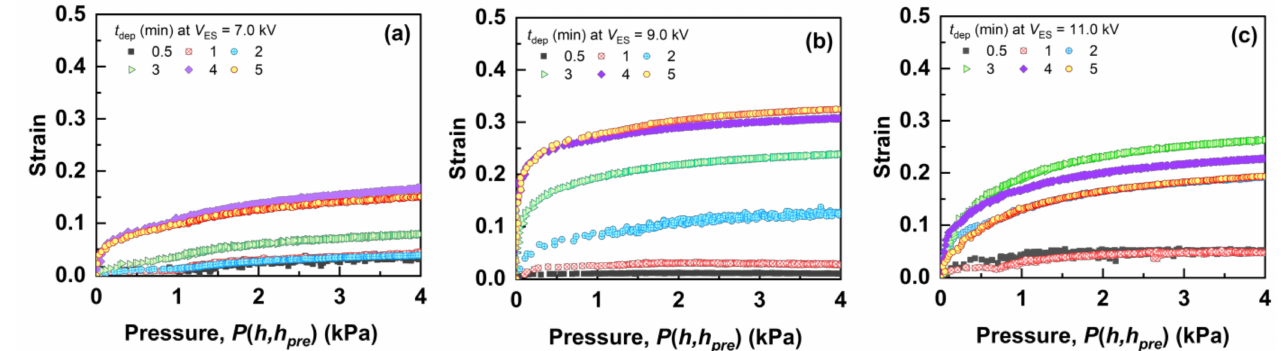
Figure 5. Strain–pressure characteristics of the fiber mats produced with different t dep and V ES .